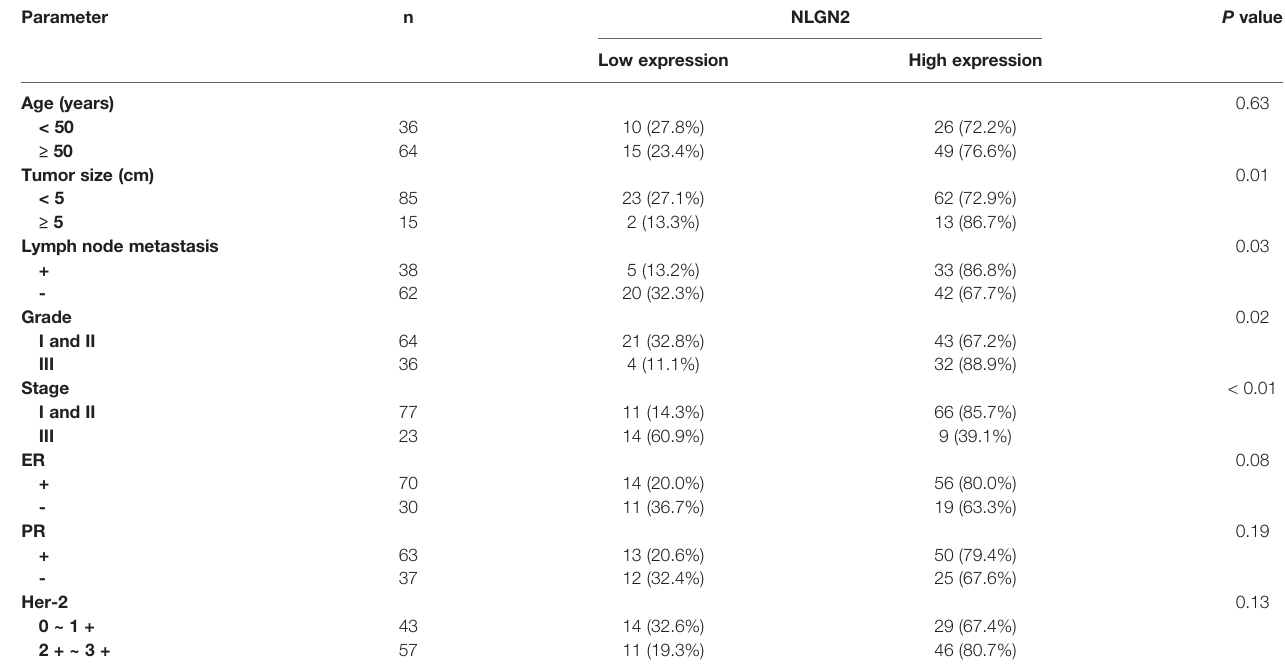
TABLE 1 | The relationship between NLGN2 expression and the clinicopathological features of breast cancer patients. Parameter